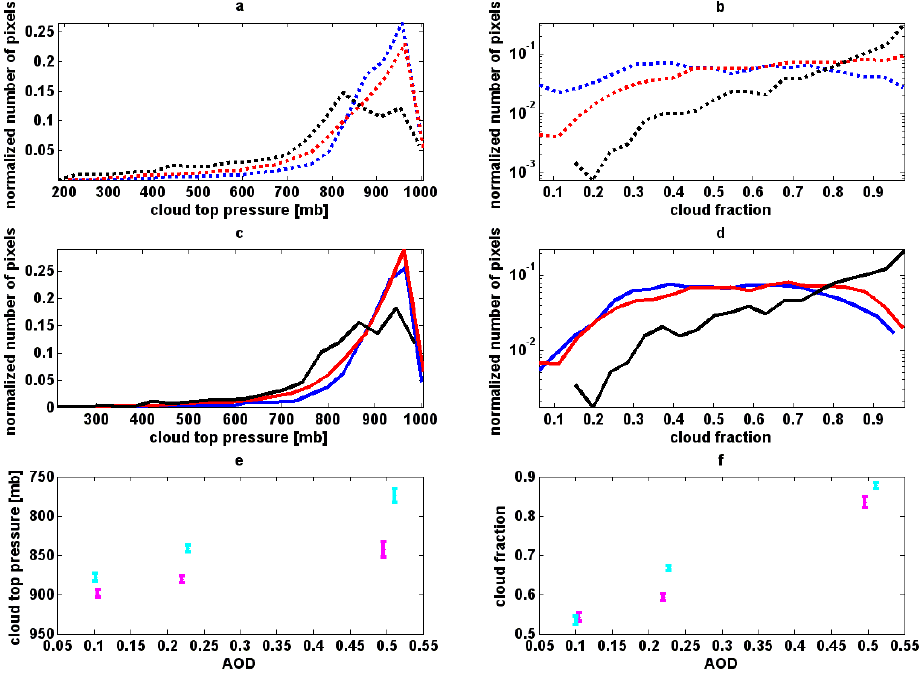
Fig. 5. Cloud properties vs. AOD for 3 AOD ranges: blue 0 < AOD < 0.15, red 0.15 < AOD < 0.35 and black 0.35 < AOD < 1. Normalized-by- area histograms of (a) cloud top pressure for “all data”, (b) cloud fraction for “all data”, (c) as in (a) but for the data subjected to the 20% cloud fraction filter (“all data filtered” and (d) as in (b) but for the data subjected to the 20% cloud fraction filter only (“all data filtered”); (e) the average cloud top pressure vs. the average AOD for all-data (cyan) and “all data filtered” (magenta). (f) average cloud fraction vs. the average AOD for all-data (cyan) and “all data filtered” (magenta). The vertical extent of the lines in (e) and (f) represents +/- one standard